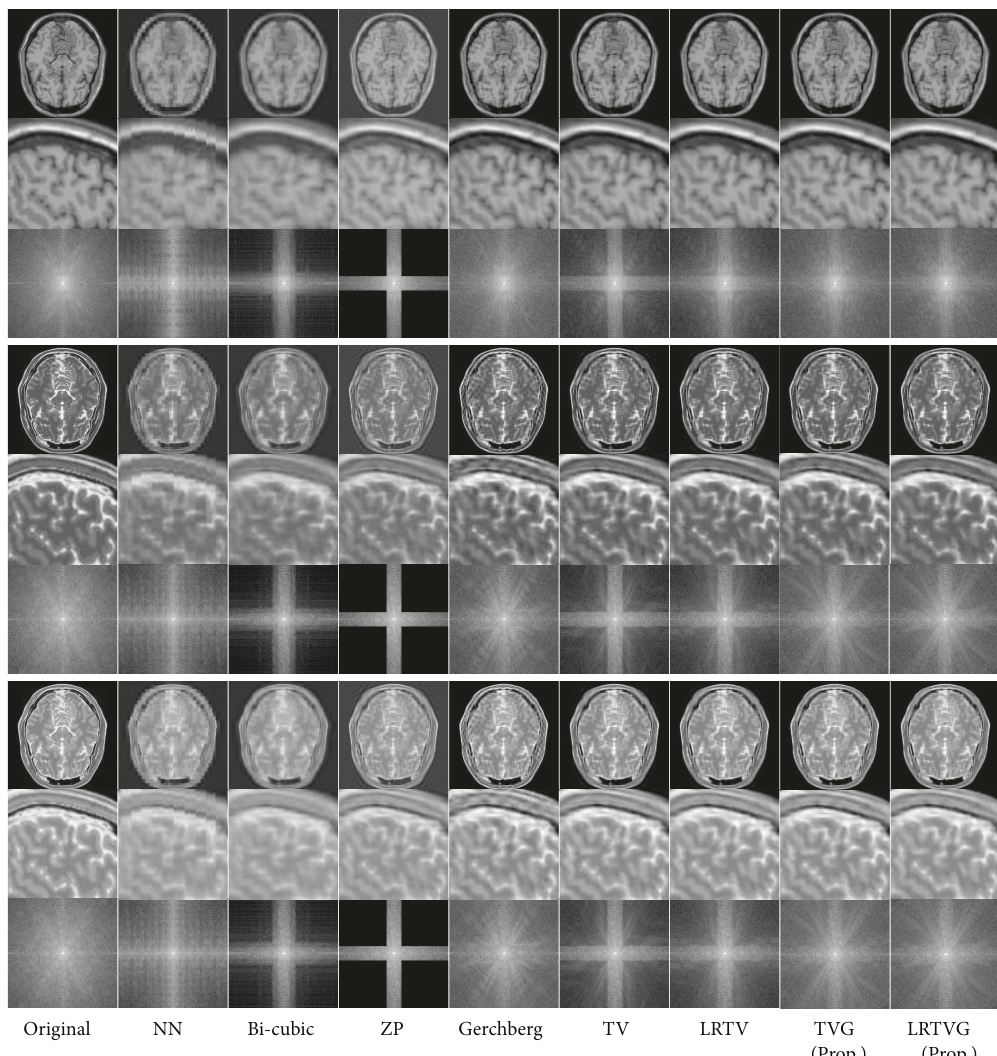
Figure 7: Reconstructed images of the brain phantom. Top three rows show illustrations of axial cross-sections, zoomed sagittal cross- sections, and the Fourier spectra of the T1-weighted brain without lesion (data (c)). The next three rows show those of the T2-weighted brain without lesion (data (k)), and the bottom rows show those of the T2-weighted brain with lesion (data (o)). 𝛽 = 8 and the noise level was 1 % for the observation settings.